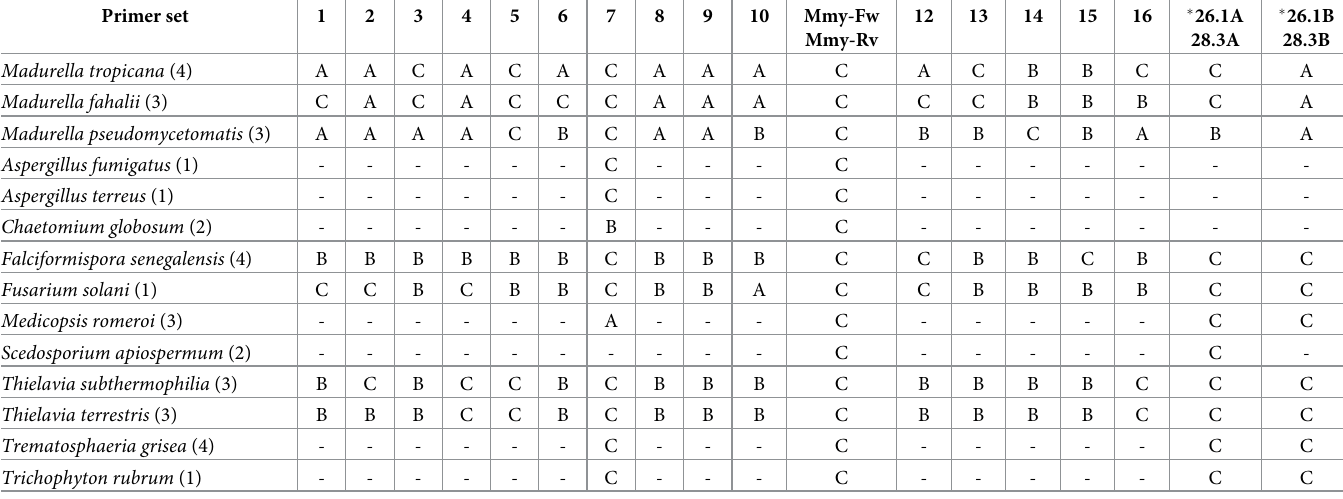
Table 2. Presence or absence of PCR amplicons of the sixteen primer sets and PCR primers developed in 1999 [5] in the other eumycetoma causing agents and close relatives of M . mycetomatis . No amplicons were observed in all species tested here using Mmy-Fw and Mmy-Rv. Only PCR with bands of the same sizes to M . mycetoma- tis is considered specific to M . mycetomatis .